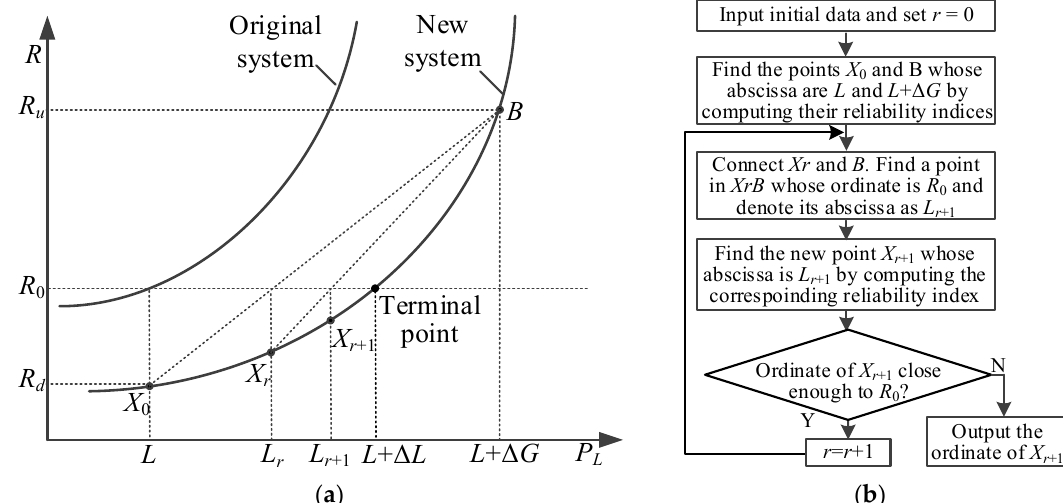
Figure 3. Illustration of the secant method. ( a ) schematic diagram of the secant method; ( b ) flowchart of the secant method. of the secant